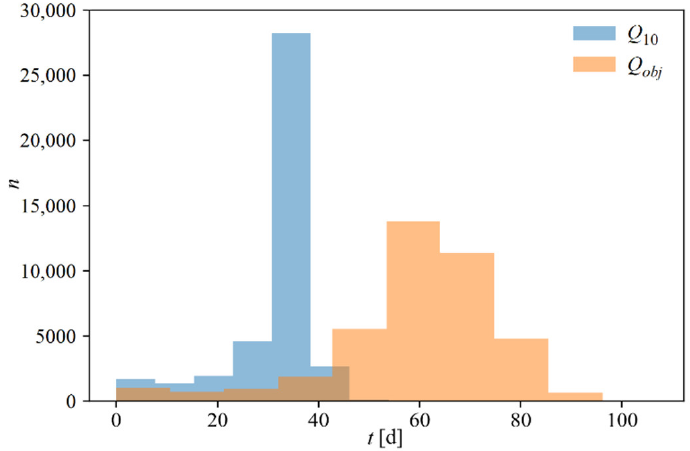
Figure 7. Annual number of days with low flow according to Q obj and Q 10 thresholds. Table 3. Descriptive statistics for the distribution of the annual number of days with low flow for